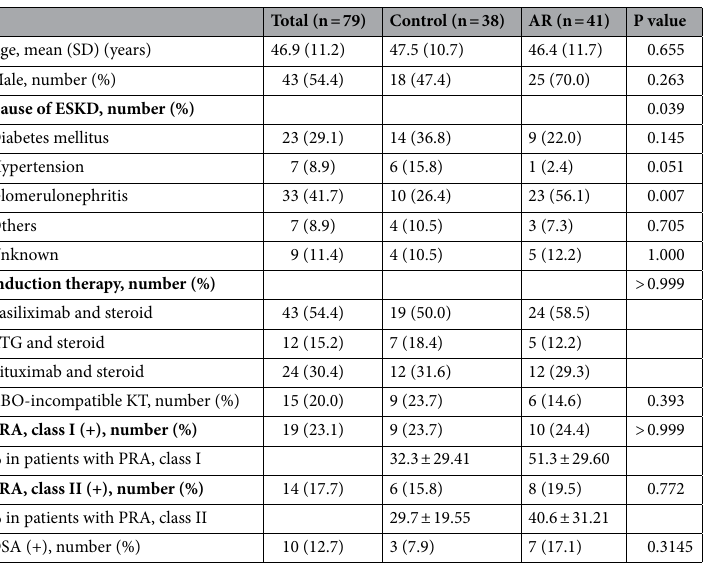
Table 3. Baseline characteristics, induction therapy for kidney transplantation, and immunologic risk factors of the validation cohort. Continuous variables are expressed as mean (standard deviation) and categorical variables are expressed as number (percentage). Others for cause of ESKD included autosomal dominant polycystic kidney disease, lupus nephritis, obstructive nephropathy, and Alport syndrome. % in patients with PRA: mean ± standard deviation. AR acute rejection, ATG anti-thymocyte globulin, DSA donor specific antibodies, ESKD end-stage kidney disease, KT kidney transplantation, PRA panel reactive antibodies, SD standard